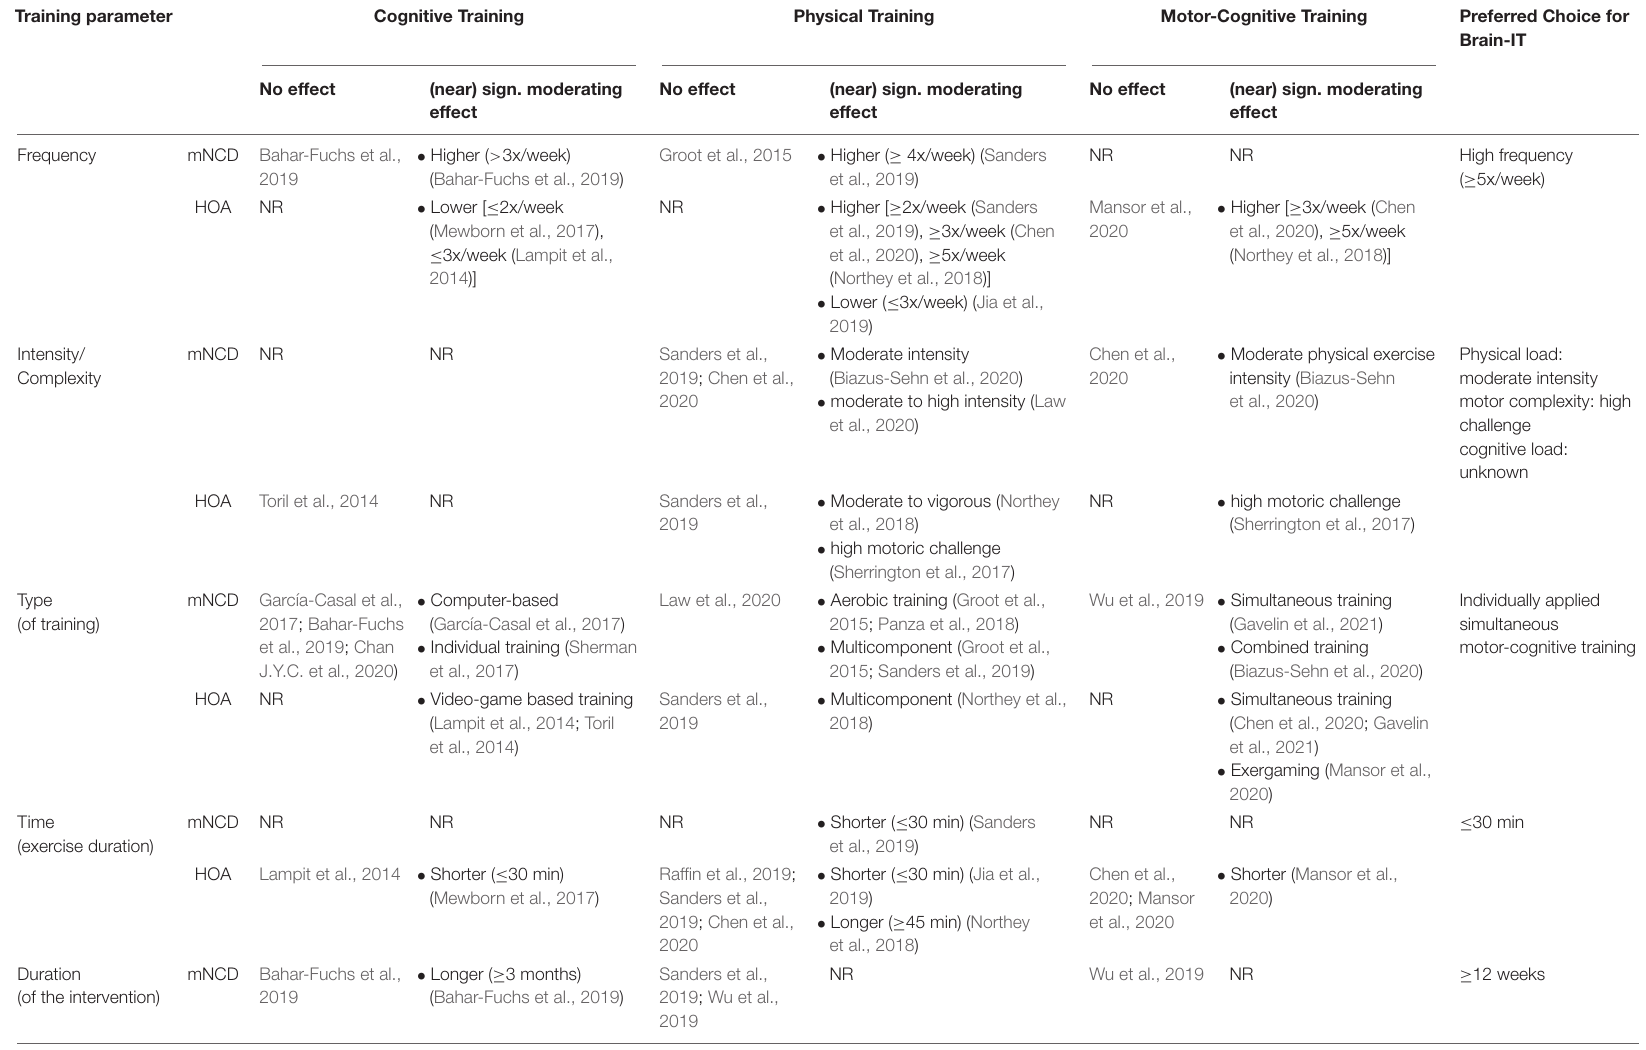
TABLE 2 | Moderating effects of exercise and training parameters on the effectiveness of cognitive, physical, and cognitive-motor training in healthy older adults and older adults with mild neurocognitive